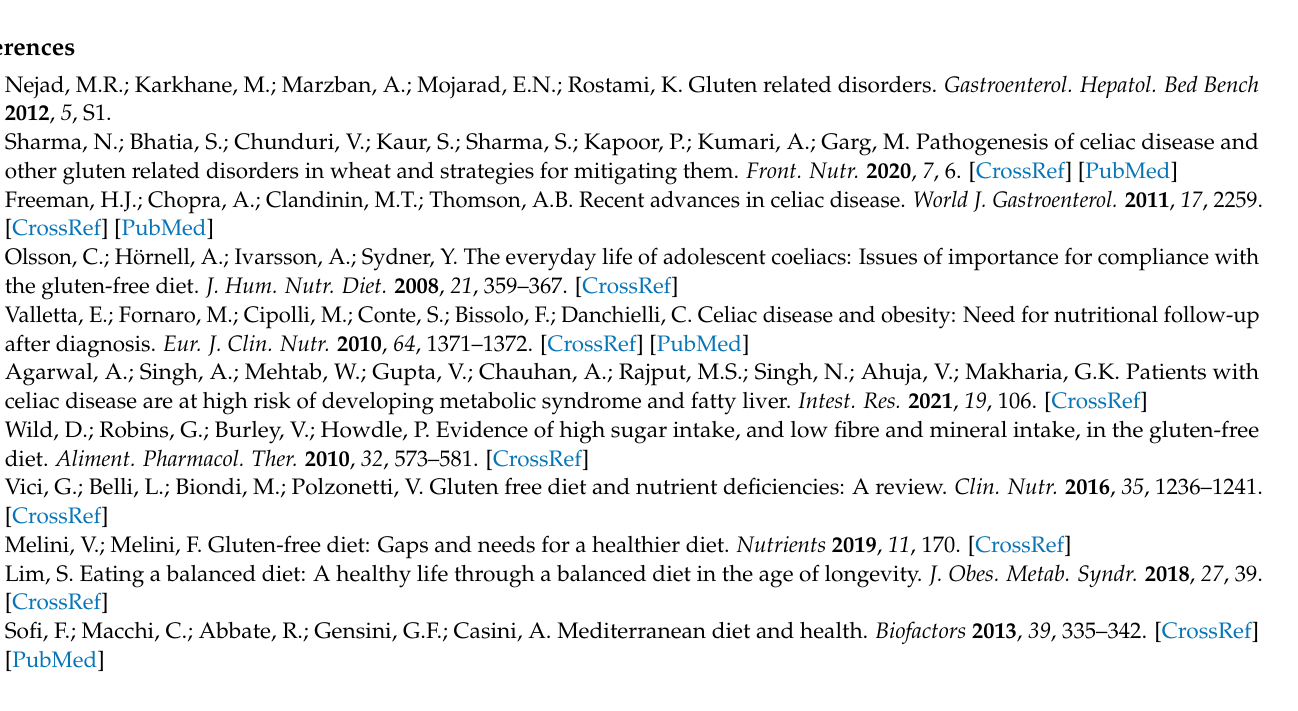
Table S2. Tukey’s multiple comparisons test of detectable carbohydrates content; Table S3. Tukey’s multiple comparisons test of detectable amylose content; Table S4. Tukey’s multiple comparisons test of detectable amylose/total CHO content after cooking